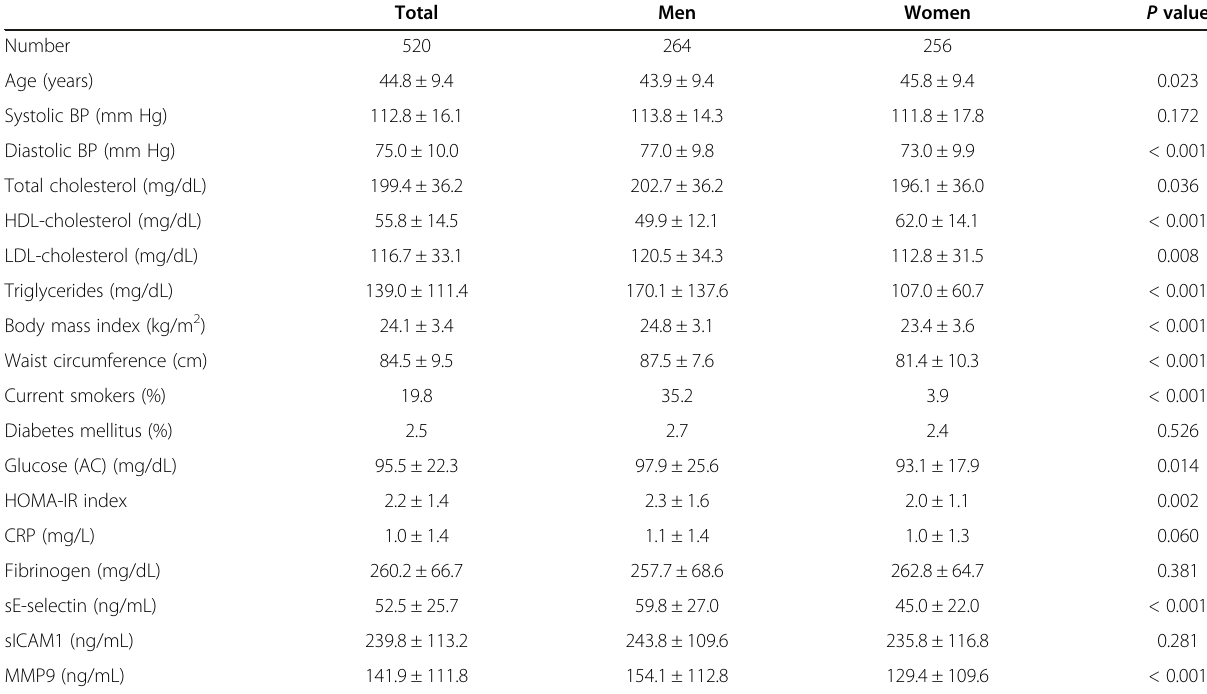
Table 1 Baseline characteristics of the study subjects